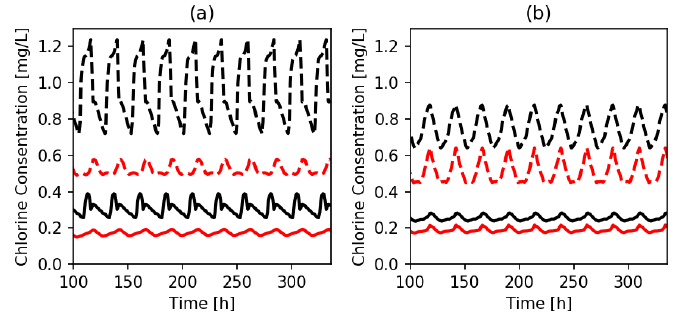
Figure 6. Chlorine concentration results using WUDESIM (red) and EPANET (black) under nominal (dashed) and reduced (solid) demand scenarios: ( a ) at J-169; ( b ) average concentration among dead-end nodes.